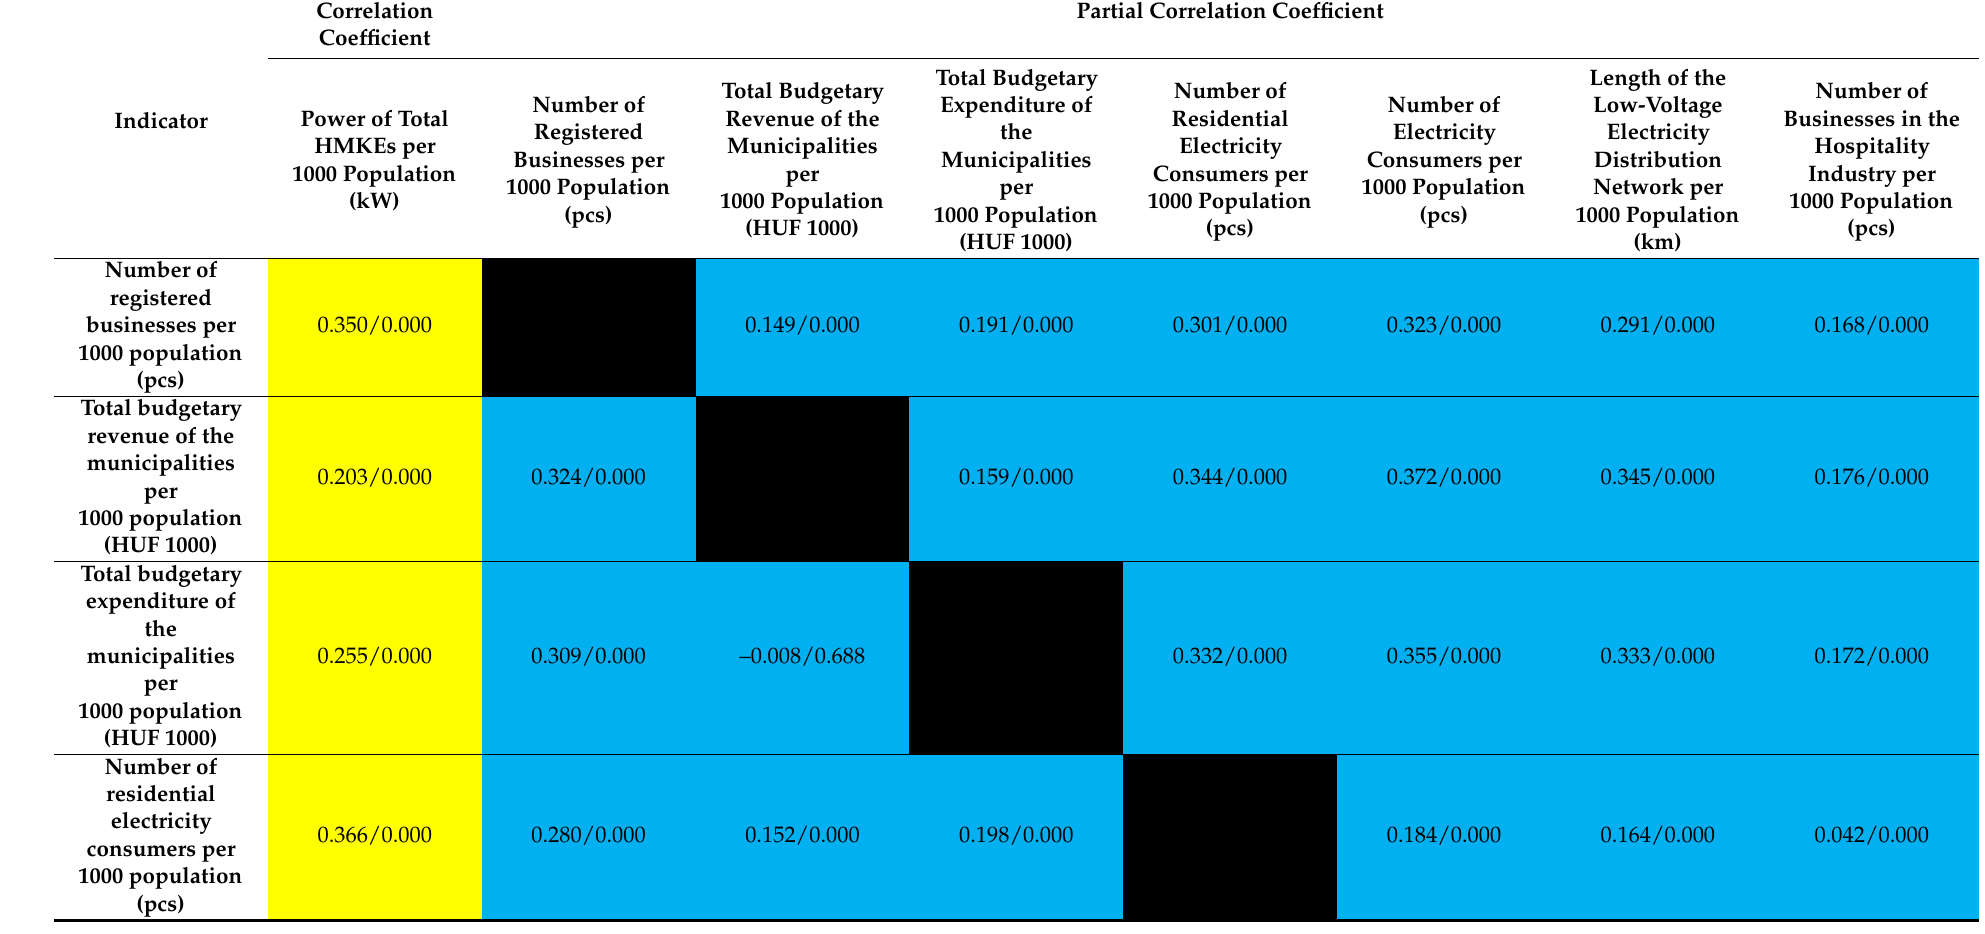
Table 4. The strengths of the relationships between the power of the total HMKE per 1000 population and the settlement indicators 1 ( 1 Pearson correlation coefficient/ p -value; if p < 0.05, then there is a significant verified relationship between the two variables) (In the case of the Pearson correlation coefficients in the table grey background indicates weak correlations and yellow means weak moderate ones.) In the case of the partial correlation the blue background signals partial explanation (the controlled variable explains the relationship between variables i and j only partially), while the black one shows irrelevant